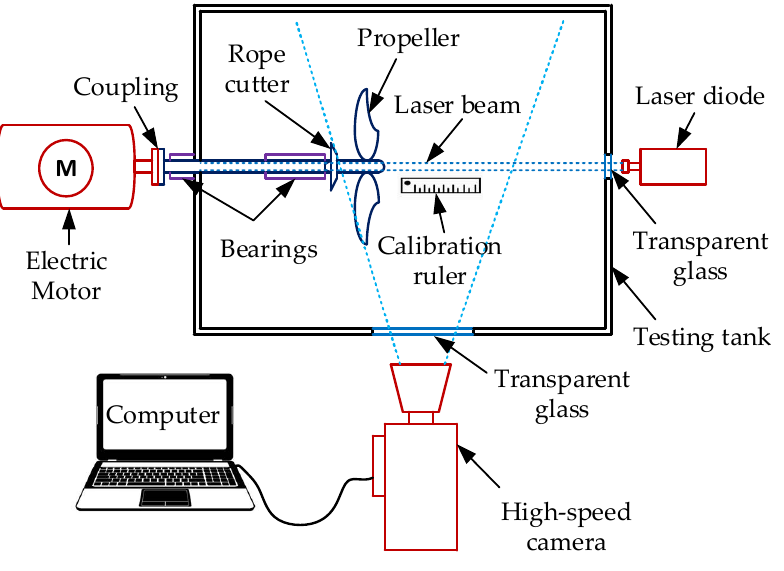
Figure 7. Schematic of the PIV experimental setup (top